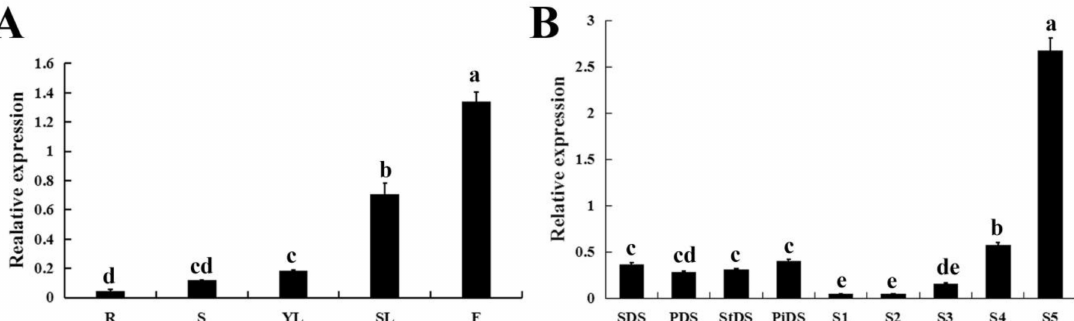
Figure 4. Expression patterns of CpWRKY71 in wintersweet. ( A ) The expression pattern of CpWRKY71 in di ff erent tissues of wintersweet. R: Roots; S: Stems; YL: Young leaves; SL: Senescing leaves; F: Flowers. ( B ) The expression pattern of CpWRKY71 in di ff erent flower developmental stages of wintersweet. SDS, PDS, StDS and PiDS represent sepal, petal, pistil and stamen primordia the di ff erentiation stage, respectively. S1–S5 represent the flower-bud, the petal-display, the initiating bloom, the bloom, the early-withering stage, respectively. CpActin and CpTublin were used as internal control. Data represent the mean of three biological repeats ± SD. Error bars indicate the standard deviation. Di ff erent lowercase letters indicate significant di ff erences ( p < 0.05).